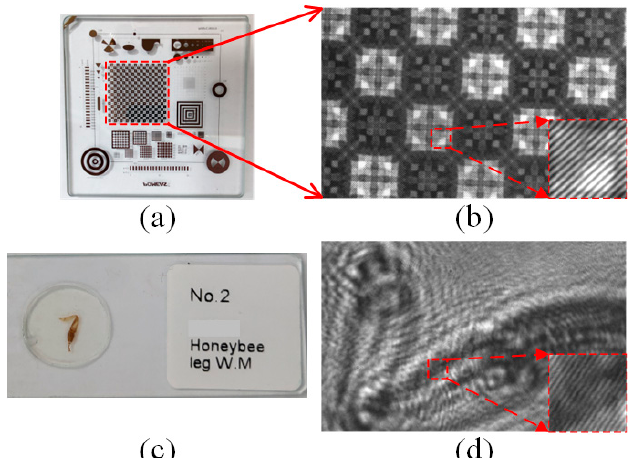
Figure 4. Experimental samples and interferograms. ( a ) Sample plate. ( b ) The interferogram of ( a ). ( c ) Honeybee foot. ( d ) The interferogram of ( c ( c ) Honeybee foot. ( d ) The interferogram of ( c ).